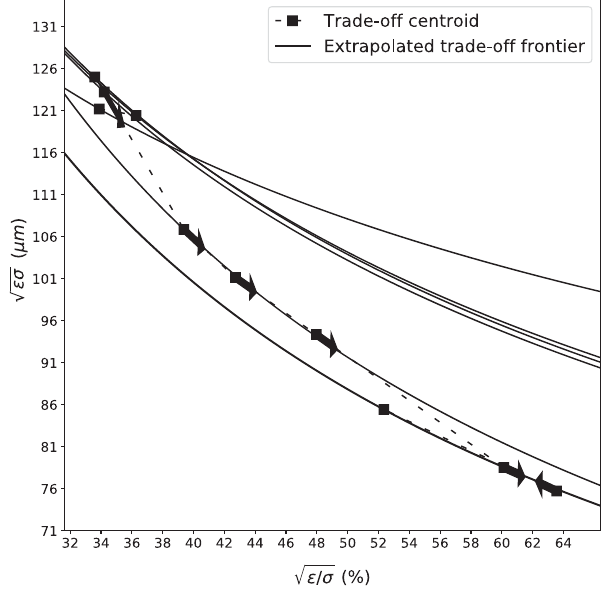
error.FIG. 9. Experimental progress of the genetic algorithm with time. Each square marks a generation of the algorithm, showing the location of the mean individual in the trade-off frontier. Arrows indicate the sequence of generations, with one generation taking 10 minutes of machine time. The x axis shows the square root of the ratio of the RMS beam size ϵ and RMS orbit error σ , while the y axis shows the square root of their product. For any given x , smaller y values are better. Solid lines show the best power-law fit ð y ¼ Ax b Þ to the trade-off frontier at each gen- eration. Much of the improvement provided by the genetic algorithm is due to reduction of the orbit error, as evidenced by the trend of the algorithm toward larger values of